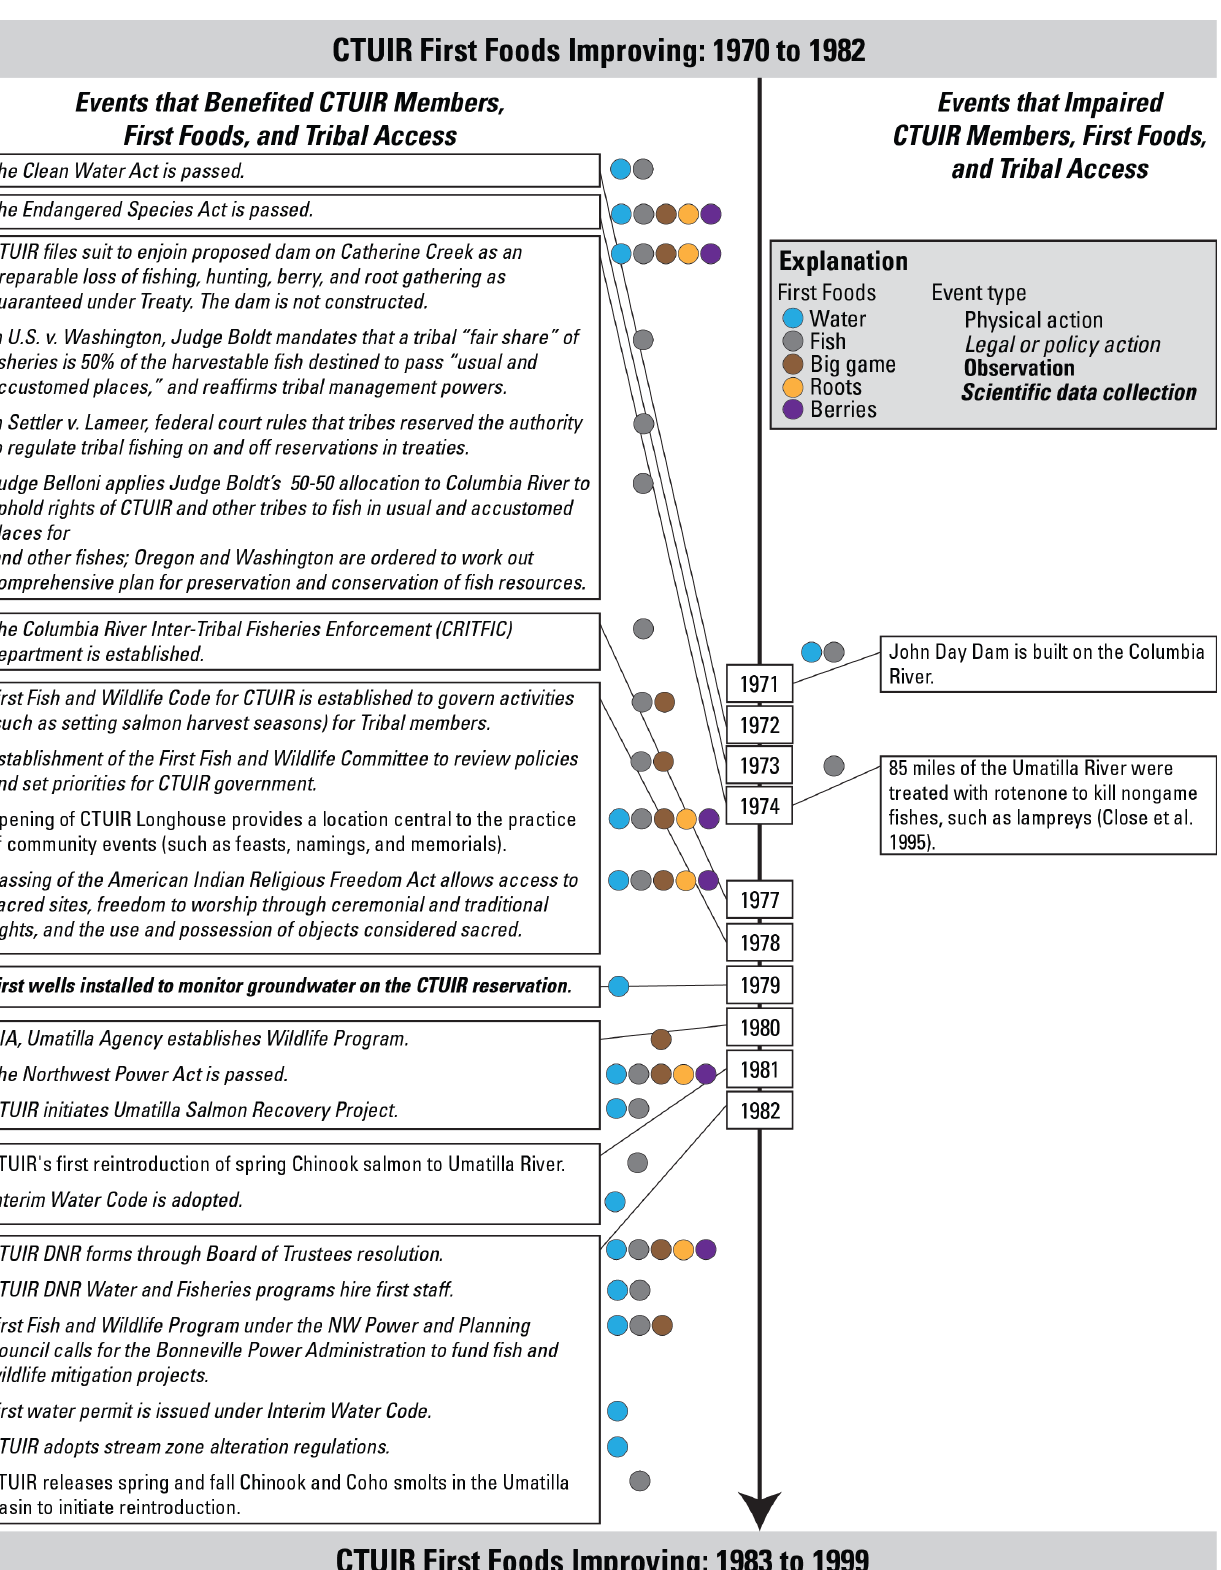
Fig. 6 . Timeline of representative events benefiting or diminishing First Foods and tribal access to them, 1970 to